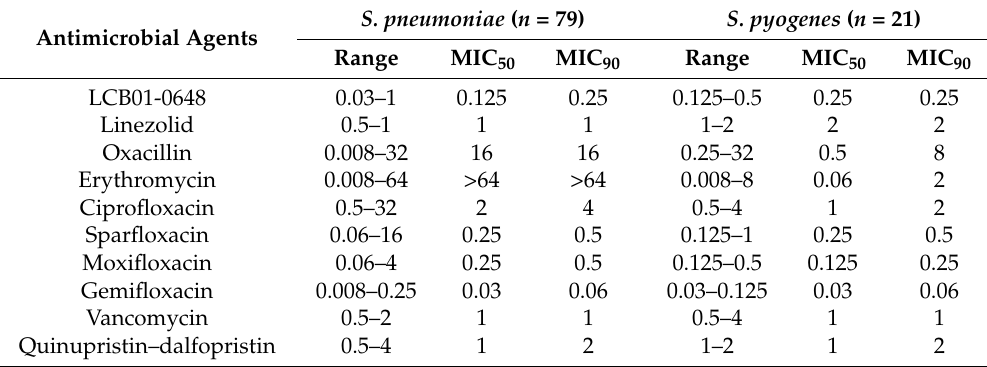
Table 2. Minimum inhibitory concentrations (MICs) of LCB01-0648, linezolid, oxacillin, erythromycin, ciprofloxacin, sparfloxacin, moxifloxacin, gemifloxacin, vancomycin, and quinupristin–dalfopristin for clinical isolates of Streptococci.